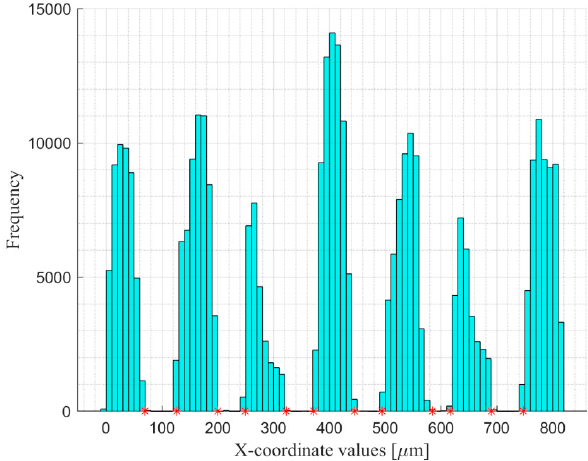
Figure 6. Distribution of the X coordinate values and the thresholds for outlier detection. Electronics 2019 , 8 , 1217